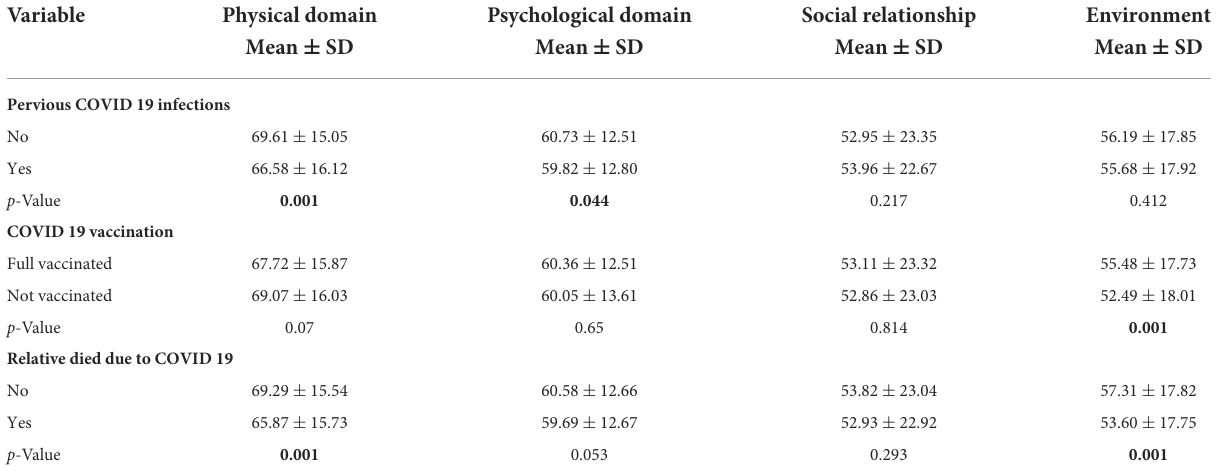
TABLE 6 COVID19 factors and quality of